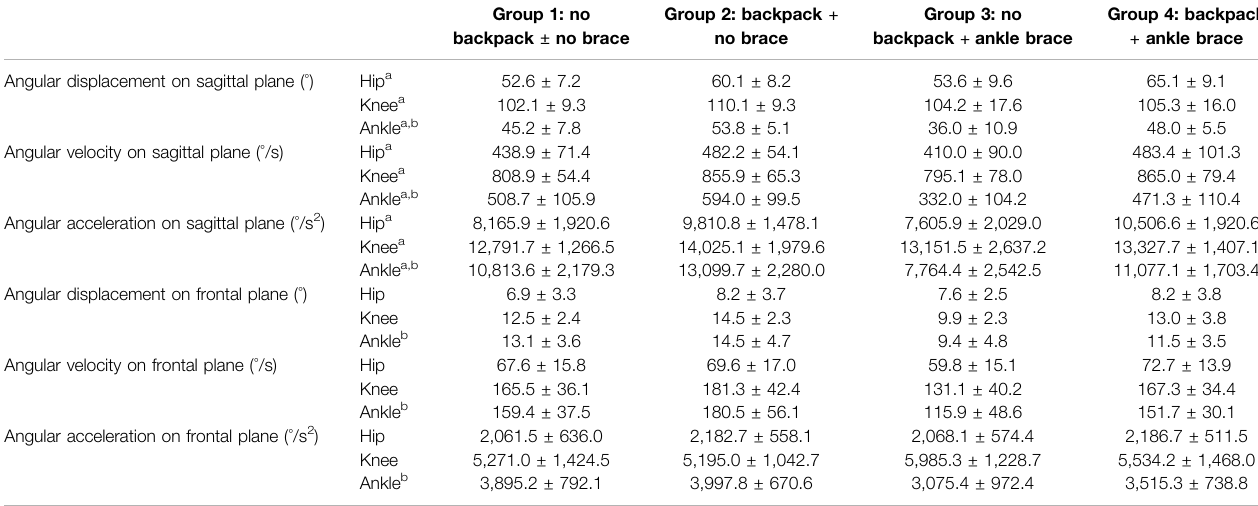
Group 1: no Group 2: backpack + Group 3: no Group 4: backpack backpack ± no brace no brace backpack + ankle brace + ankle brace